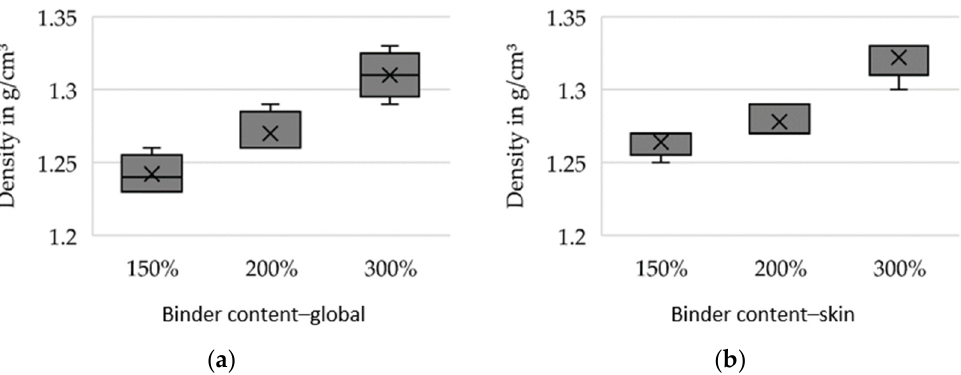
Figure 8. Density of specimens produced at varying binder contents. The binder content was increased ( a ) globally and ( b ) only in an outer skin of 5 mm.